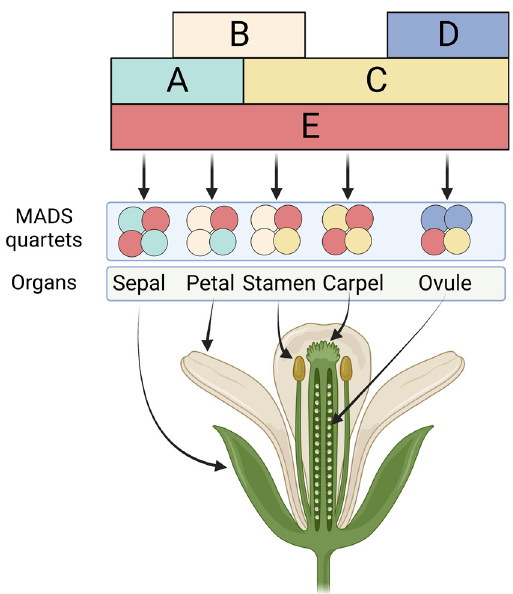
Figure 1. The ABCDE model of floral organ identity specification. The identity of the different floral organs is specified by the combinatorial activity of A-, B-, C-, D-, and E-class genes (as indicated). The MADS-domain transcription factors encoded by these genes act together in different tetrameric complexes (‘quartets’) to control the developmental programs needed for the formation of sepals, petals, stamens, carpels, and ovules. Colors indicate the composition of the different MADS-domain protein quartets. Figure created with BioRender.com.